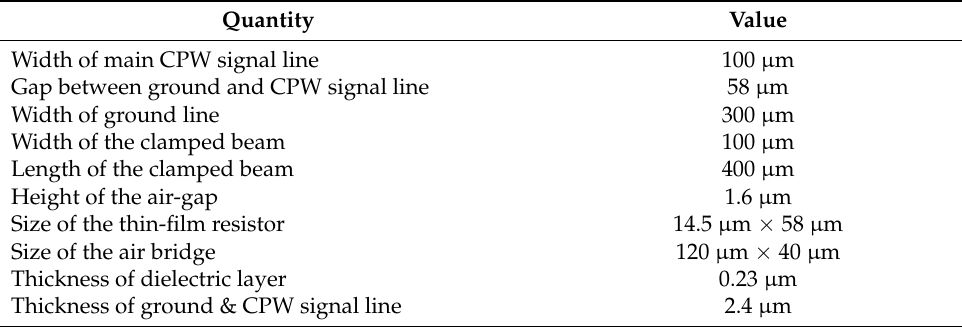
Table 1. Structural parameters for cascaded MEMS amplitude